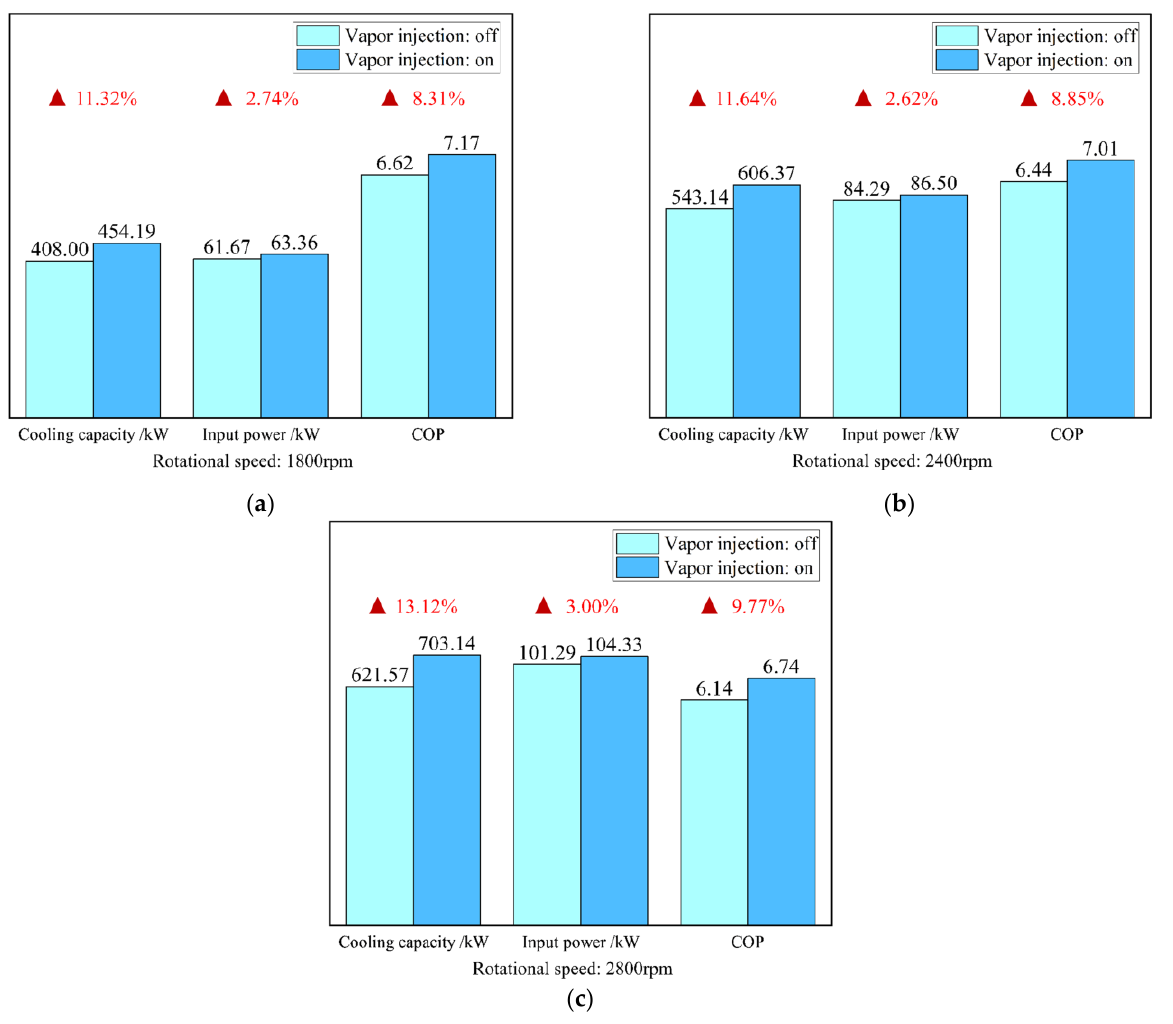
Figure 14. Performance test results of the chiller under the conditions of on/off vapor injection: ( a ) rotational speed of 1800 rpm; ( b ) rotational speed of 2400 rpm; ( c ) rotational speed of 2800 rpm.